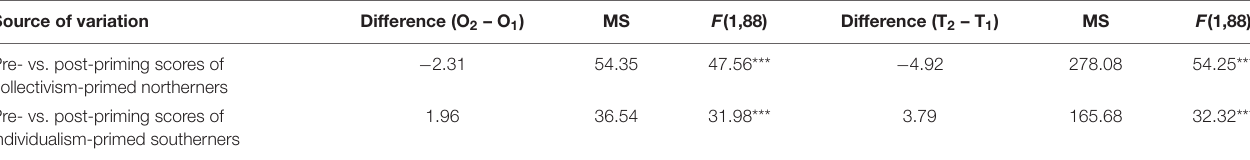
TABLE 2 | Results of planned contrasts (original and standard EFT scores).